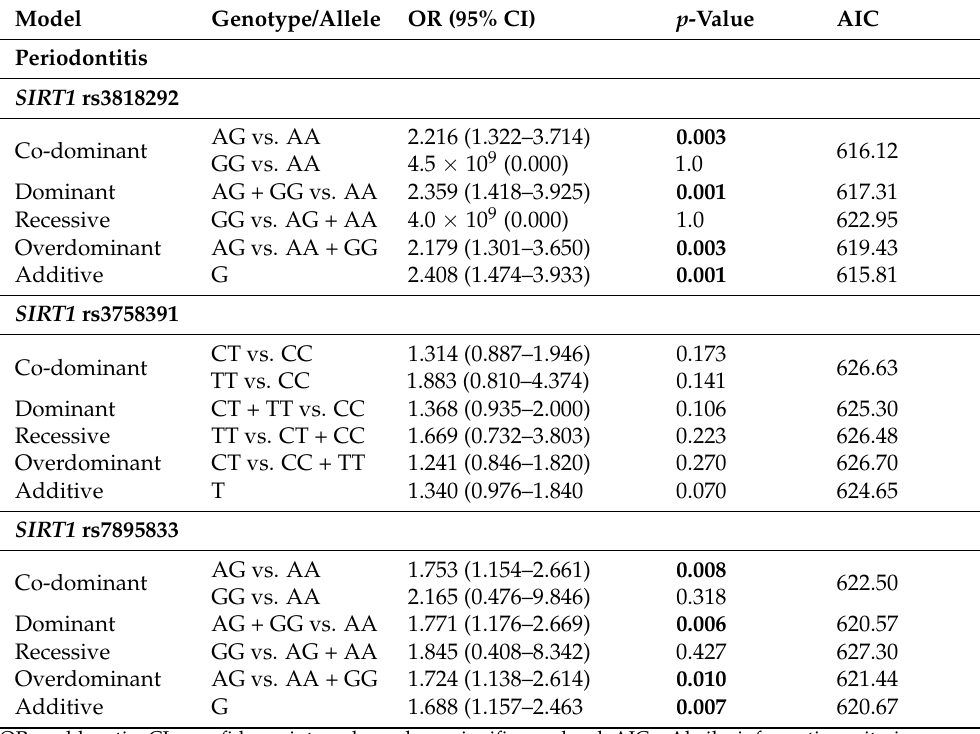
Table 8. Binomial logistic regression analysis of periodontitis and control groups in the older than 60-year-old patients’ group.